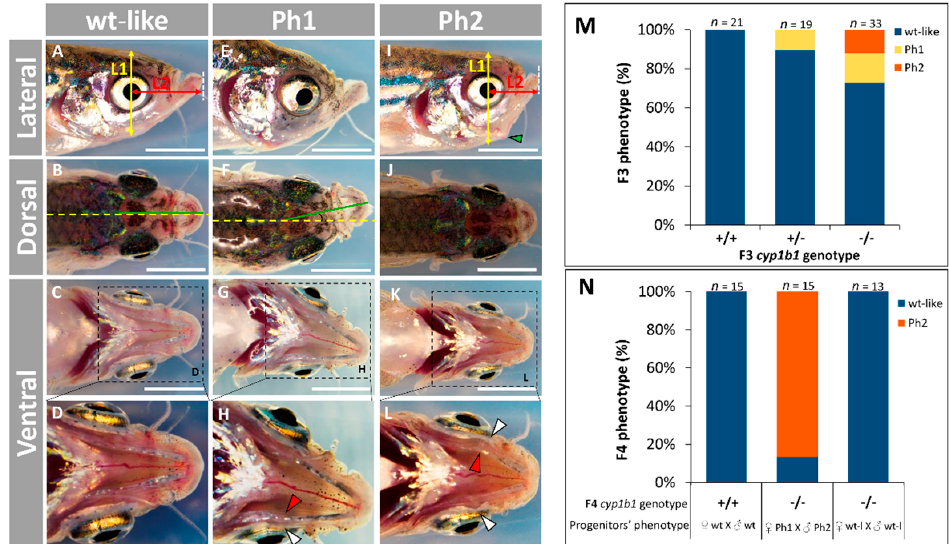
Figure 5. Adult (four months) craniofacial phenotypes in the established cyp1b1 -KO zebrafish line (F3 and F4). ( A – L ) Phenotypes of homozygous (-/-) cyp1b1 -KO F3 zebrafish. ( A ) Lateral craniofacial shape was assessed by the L1/L2 ratio, where L1 (yellow line) is the dorsoventral head length centered in the pupil and L2 (red line) is the anteroposterior head length from the center of the pupil to the end of the lower jaw (white dashed line). ( B ) Jaw asymmetry was evaluated measuring the dorsal angle (da) formed between the longitudinal central body axis (yellow dashed line) and an imaginary line linking the supraoccipital axis and the joining point of the two Meckel’s cartilages (green line). ( C , D ) Ventral morphology of wild type-like head. ( E – H ) Phenotype 1 (Ph1) was characterized by jaw asymmetry, i.e., da > 5 ◦ , which is clearly visible in ( F ). ( I – L ) Phenotype 2 (Ph2) was identified by altered craniofacial shape defined as the L1/L2 ratio > 1.87, which is 15% higher than the mean value (1.63) in wildtype zebrafish. White arrowhead: altered quadrate bone. Red arrowhead: altered palatoquadrate bone. ( M ) Percentage of F3 craniofacial phenotypes. ( N ) Percentage of F4 craniofacial phenotypes. F3 cyp1b1 -KO siblings with mutant or wild type-like phenotypes were inbred to obtain the F4 KO progeny (-/-). Wildtype (+/+) F3 progenitors were crossed in parallel as a control. The images in ( A – L ) are representative of the results observed in 33 homozygous (-/-) cyp1b1 -KO F3 zebrafish. Scale bar = 2.5